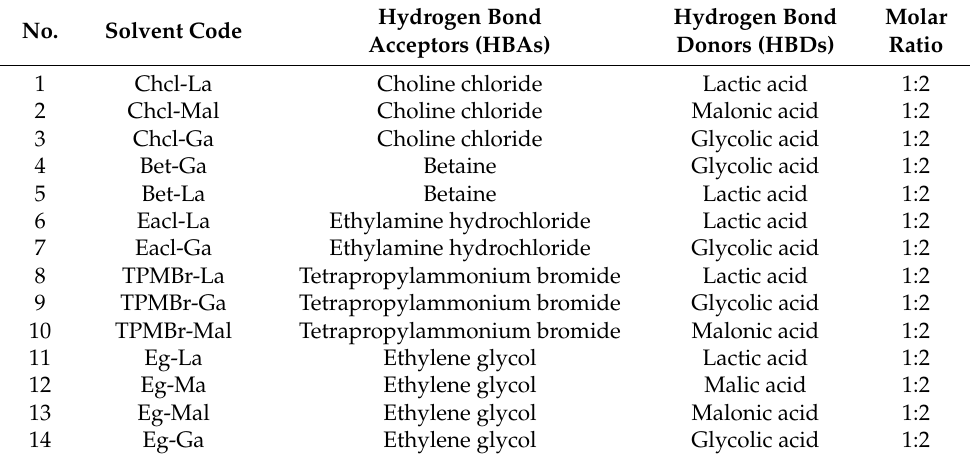
Table 1. Composition and solvent code for the studied